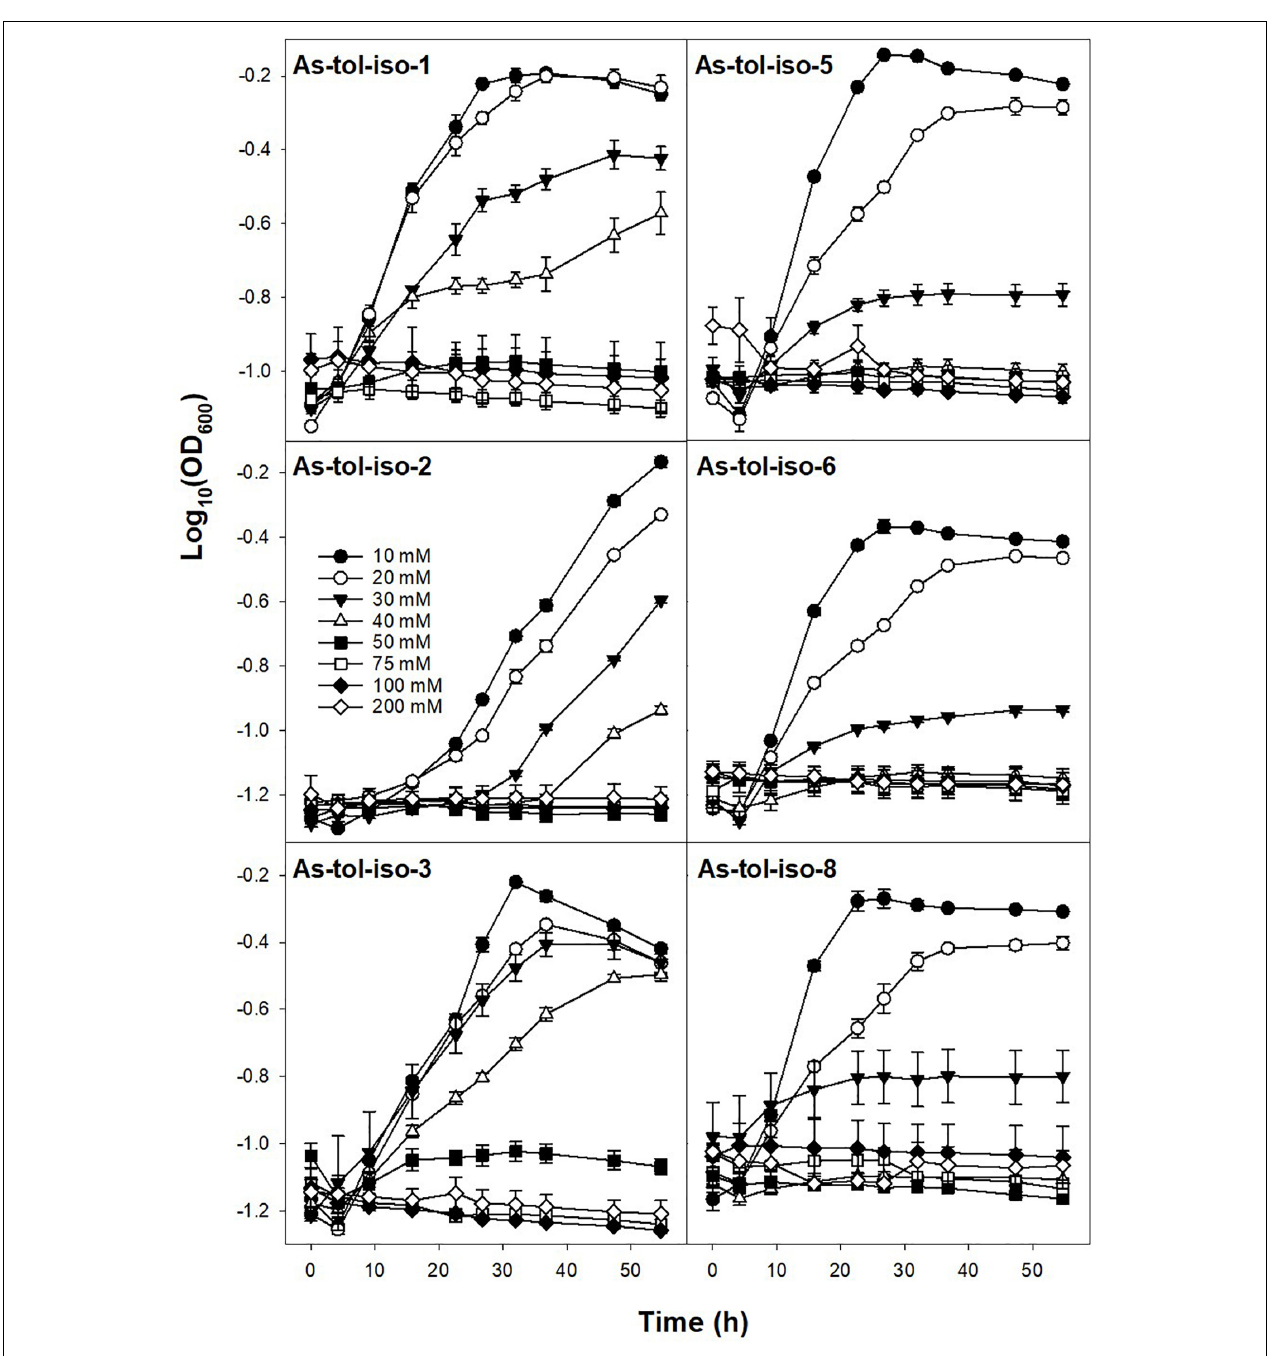
FIGURE 6 | Effect of arsenite concentration on the growth of isolated arsenic-tolerant peat microorganisms. Strains were incubated in medium for arsenic-tolerant microorganisms supplemented with 10–200 mM arsenite and 10 mM arsenate at 20 ◦ in the dark. Mean values and standard errors of three replicates are